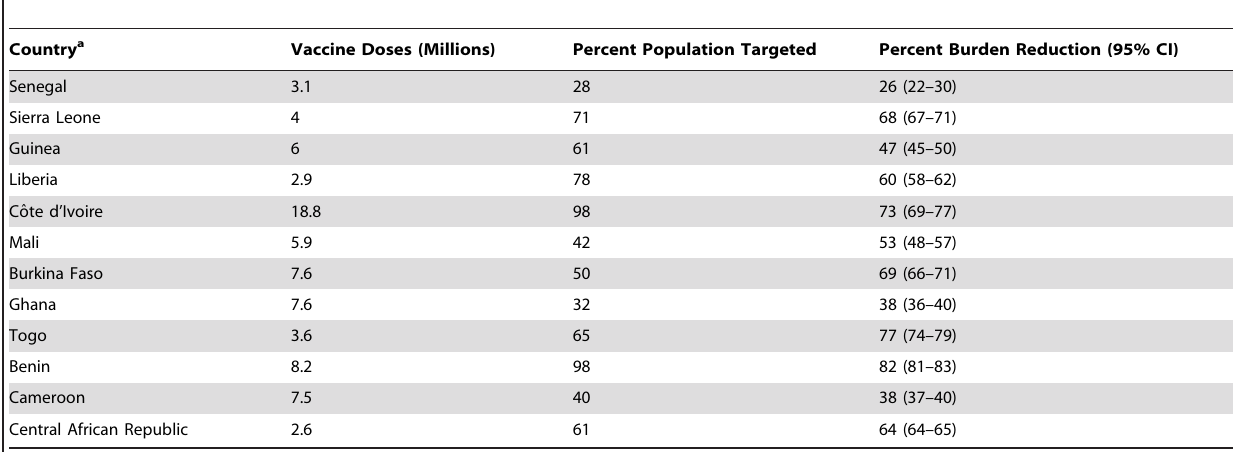
Table 3. Number of yellow fever vaccine doses procured for use in preventive vaccination campaigns from 2006 to 2012, percentage of the national population targeted and burden reduction achieved in 2013, by country.